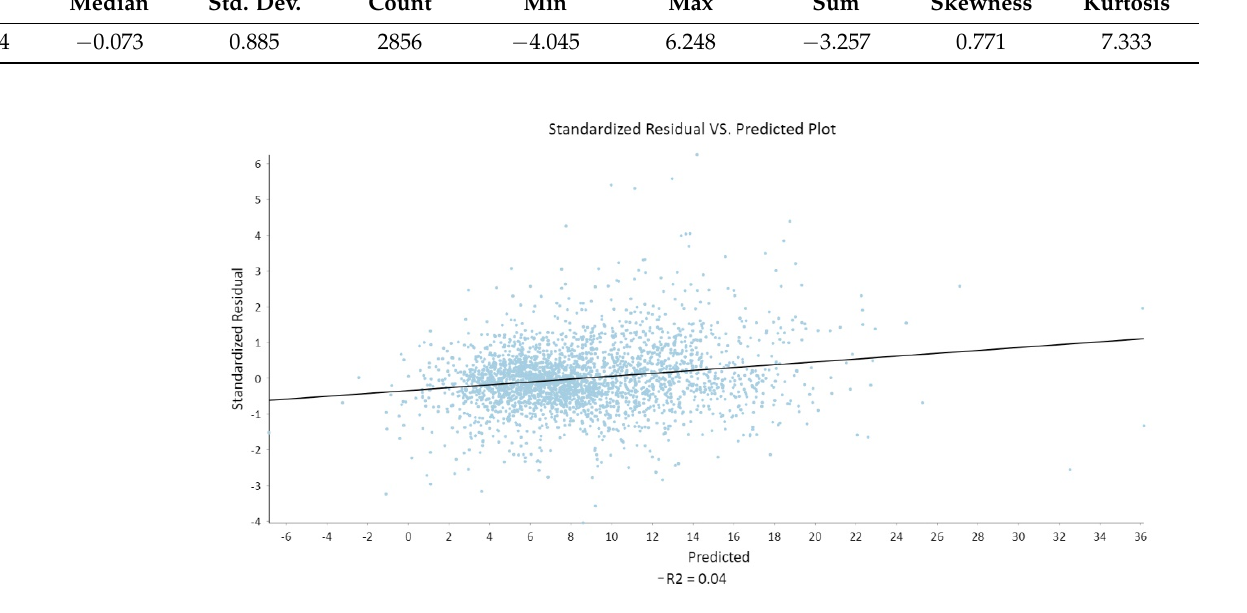
Figure 11. Scatterplot of the GWR standardized residuals.